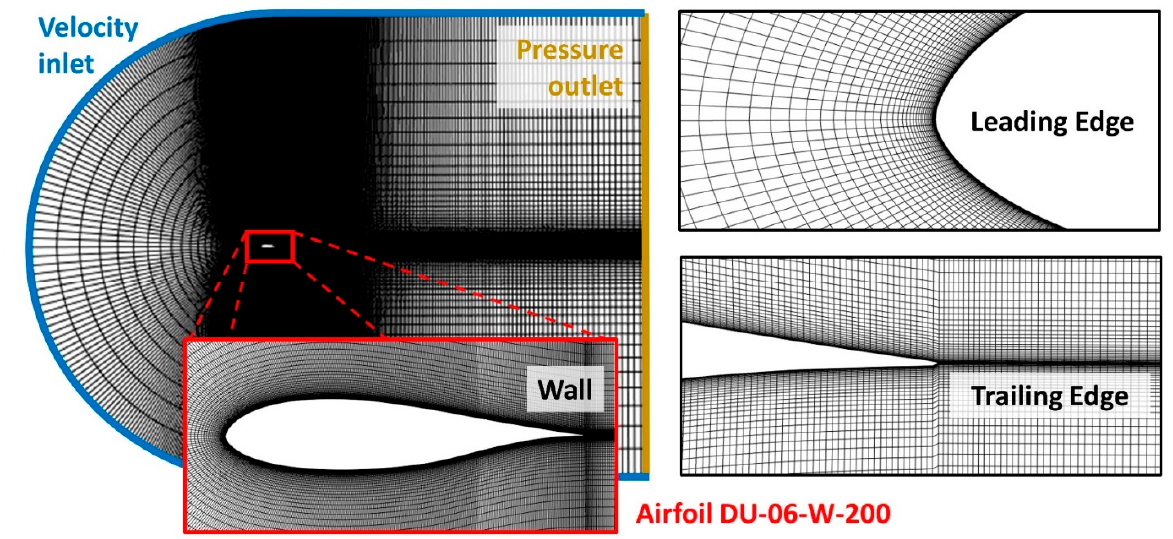
Figure 4. CFD simulation mesh detail views and boundary conditions.